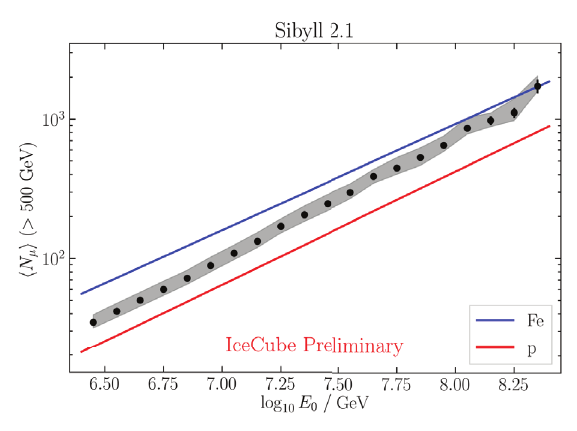
Figure 10: (cid:4) N μ (cid:5) with energy larger than 500 GeV as a function of primary energy [12], obtained from experi- mental data with Sibyll2.1 [4] simulation. Error bars in- dicate the statistical uncertainty and the band indicates the total systematic uncertainty.